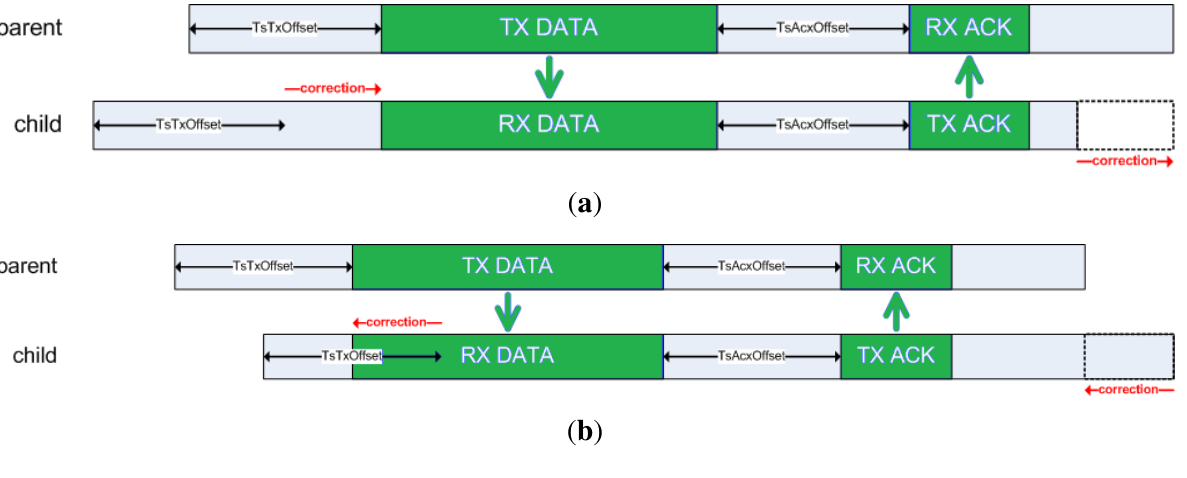
Figure 4. Acknowledge (ACK) synchronization diagram. ( a ) ACK